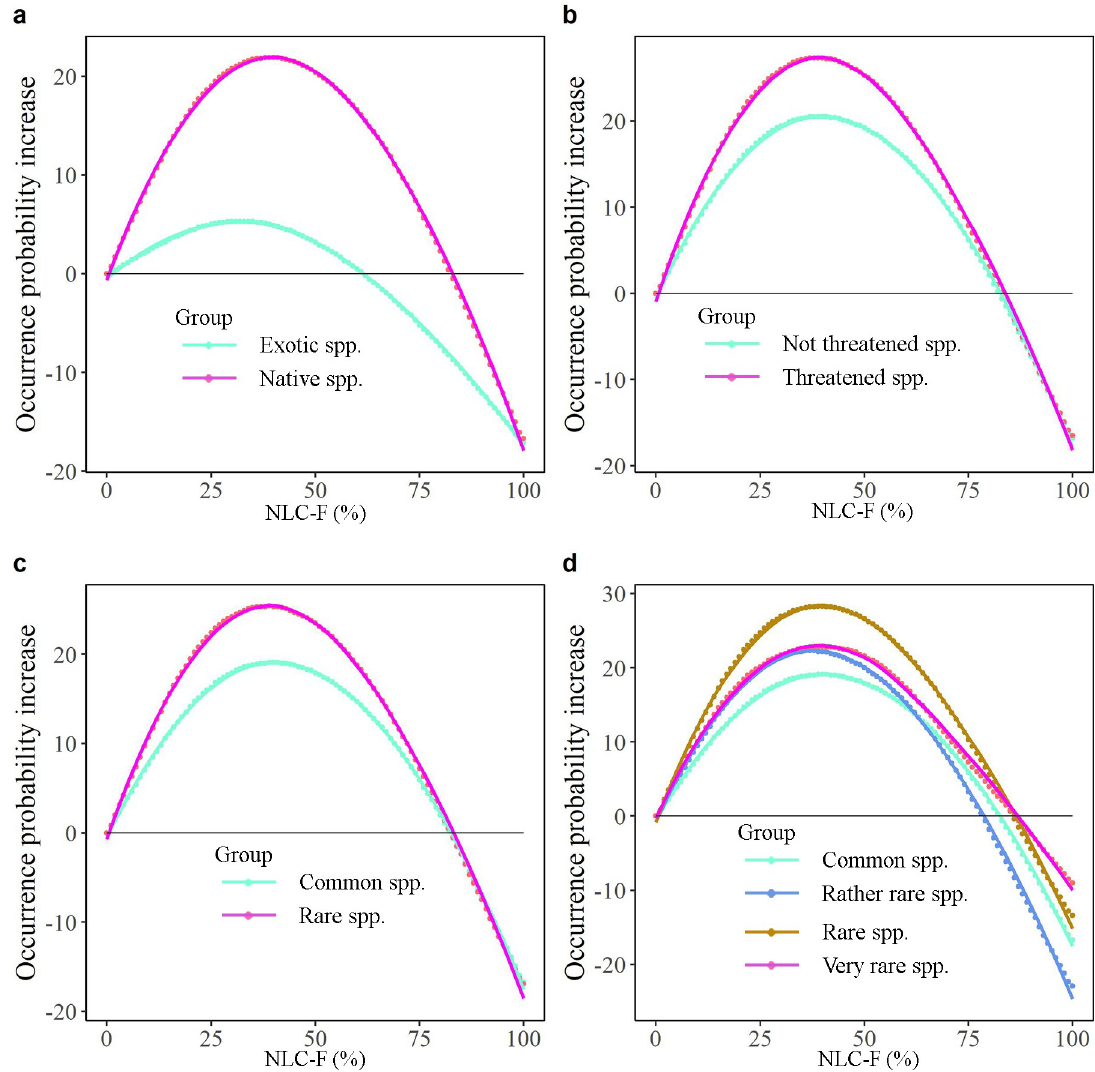
Fig 9. The average occurrence probability change (average occurrence probability change from 0% NLC-F to others, e.g. the NLC-F increases from 0% to 11%) of different species groups. a, all native species vs exotic species. b, threatened species vs not threatened species. c, rare species vs common species. d, Rare species vs common species, but rare species are classified into three categories (i.e. very rare, rare, rather rare) according to the Red List of Vascular Plants of the Netherlands [26]. Lines represent the best-fit